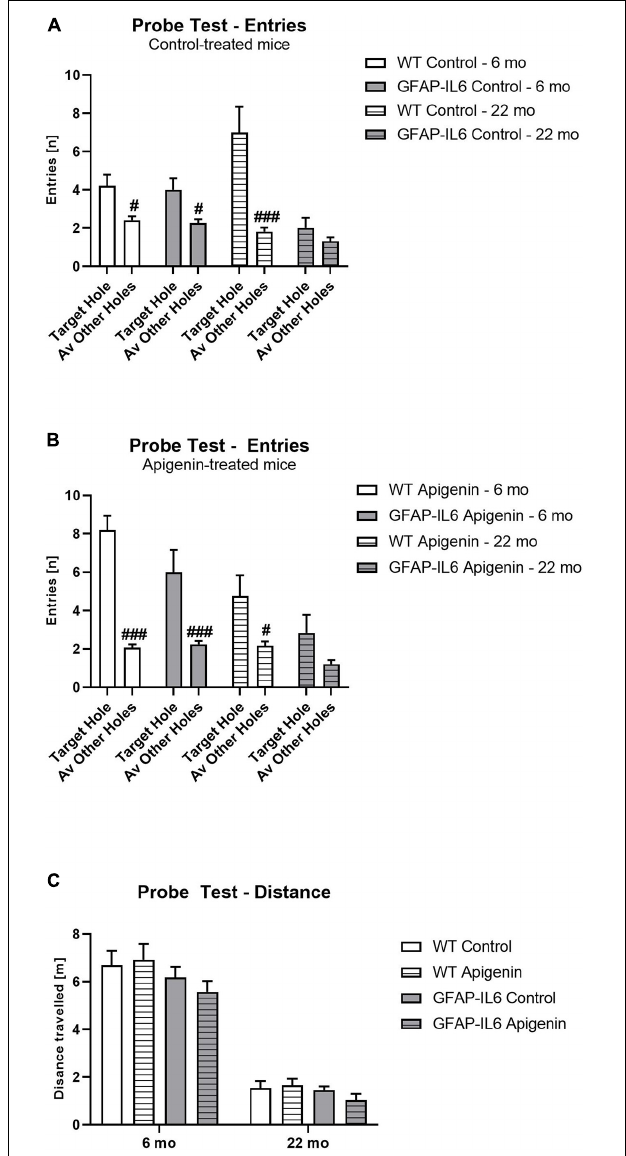
FIGURE 2 | (A–C) Effect of age and apigenin diet on Barnes Maze Probe Test Performance in WT and GFAP-IL6 mice. Entries (n) into the escape hole is presented for (A) control and (B) apigenin-fed mice. Distance traveled (m) at Probe for all groups is presented in (C) . A main effect of genotype and age in (C) indicates reduced distance traveled in GFAP-IL6 mice compared to WT controls, and reduced distance traveled in 22-month-old mice compared to 6-month-old mice. Data analyzed with three- and four-way ANOVA, followed by Bonferroni post hoc tests. Post hoc effects of “location” within the same age and treatment group are indicated by hash symbols (# p < 0.05, ### p < 0.001). Data presented as means ± SEM.